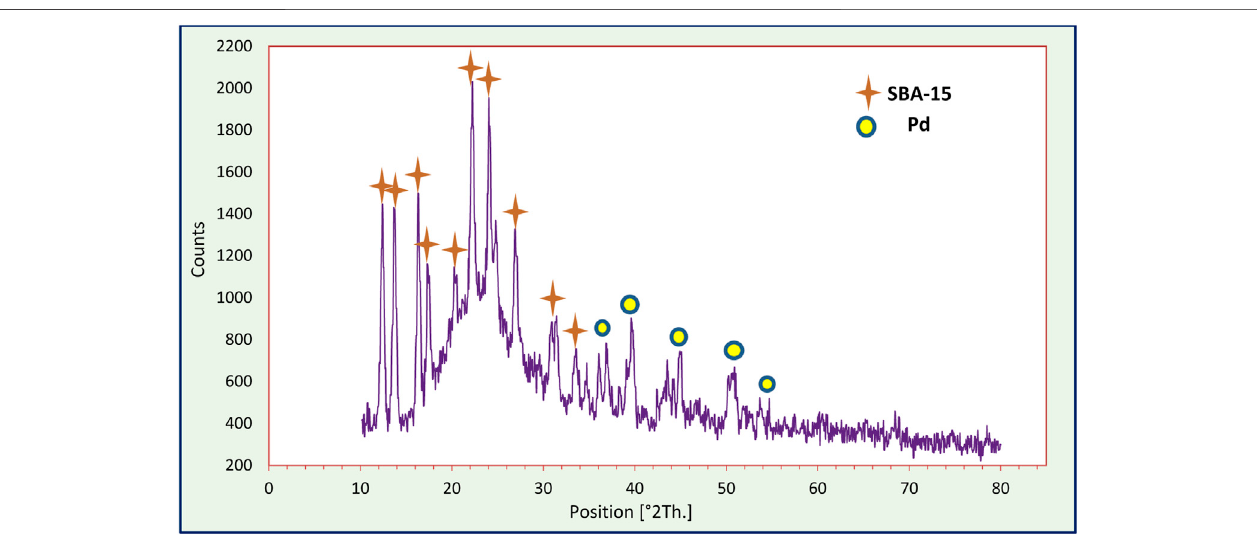
FIGURE 5 | The XRD spectrum of the organometallic nanocatalyst Pd/TCH-pr@SBA-15.